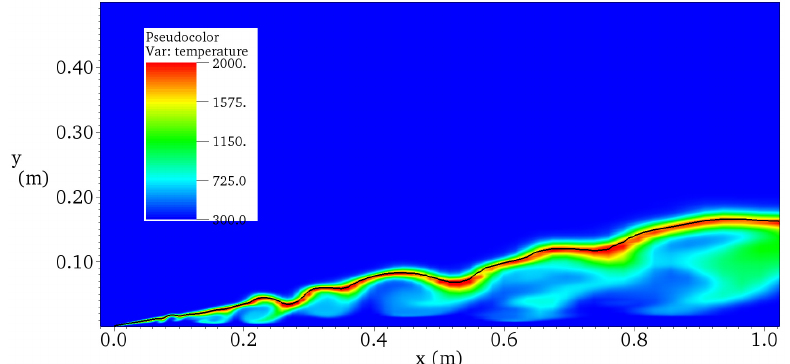
Figure 15. Typical instantaneous temperature contours in the cross section at 0 z = m.